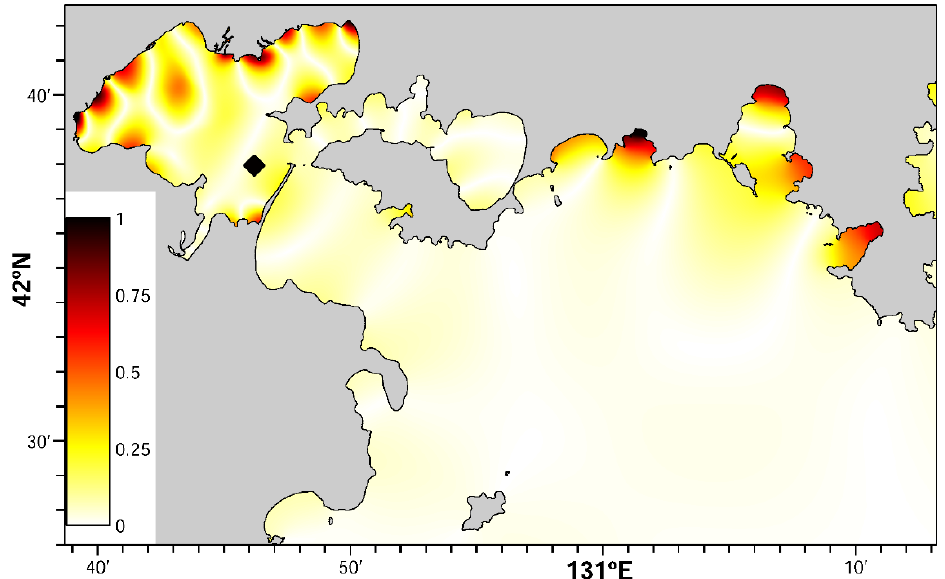
Figure 6. Distribution of oscillation amplitude with the period of 15.29 min during the meridional wind. Diamond—point of oscillation measurements.